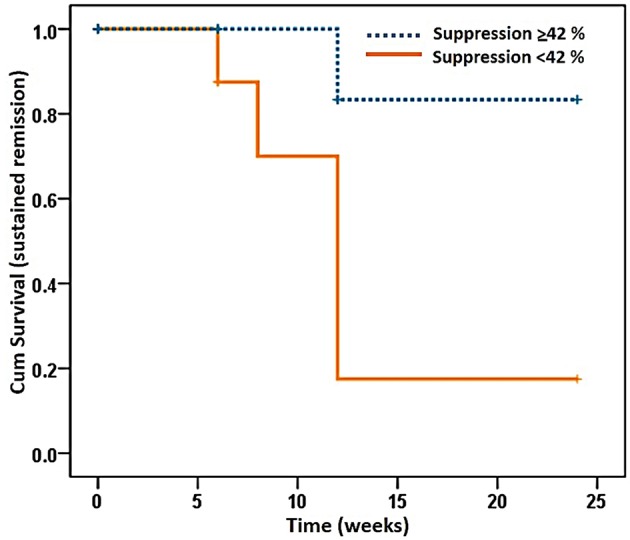
Kaplan–Meier plot of a proportion of rheumatoid arthritis patients in ongoing remission over the study period of 24 weeks. Patients were divided into those with a Treg suppressive activity (Suppression) of <42 and ≥42%. Percentage of Treg suppressive activity was determined as described in the legend to Figure 2. P < 0.05; 95% confidence interval: 9.64–14.36, Kaplan–Meier analysis.